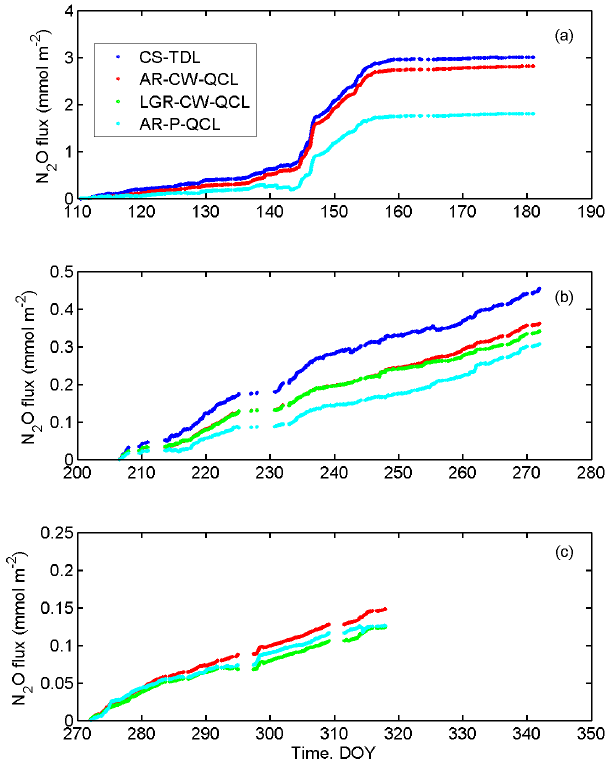
Figure 8. Cumulative sums of available flux data for three peri- ods: (a) period I DOY 110–181 (20 April–30 June 2011), (b) pe- riod II DOY 206–271 (25 July–28 September 2011) and (c) period III DOY 272–324 (29 September–20 November 2011). Accumula- tion of fluxes for each instrument was performed only for data if measurements were available for all instruments used in respective period. No gap filling was